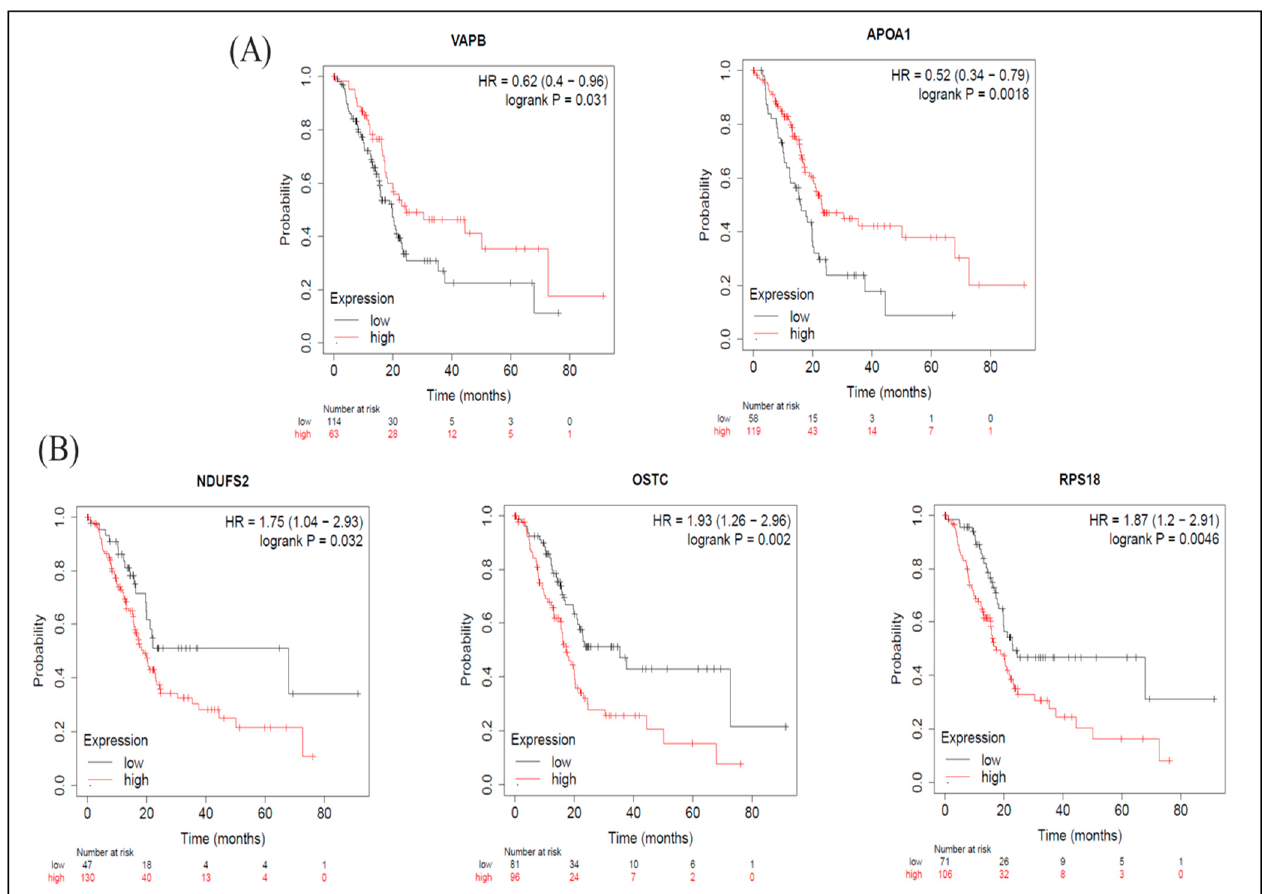
Figure 6. Meta-analysis of betulinic acid (BA)-induced upregulated proteins in overall survival (OS) in pancreatic ductal adenocarcinoma (PDAC) databases of the KM plotter. ( A ) High expressions of VAPB ( p = 0.031) and APOA1 ( p = 0.002) were associated with greater OS. ( B ) Contrarily, high expressions of NDUFS2 ( p = 0.032), OSTC ( p = 0.002), and RPS18 ( p = 0.005) were associated with worse OS.